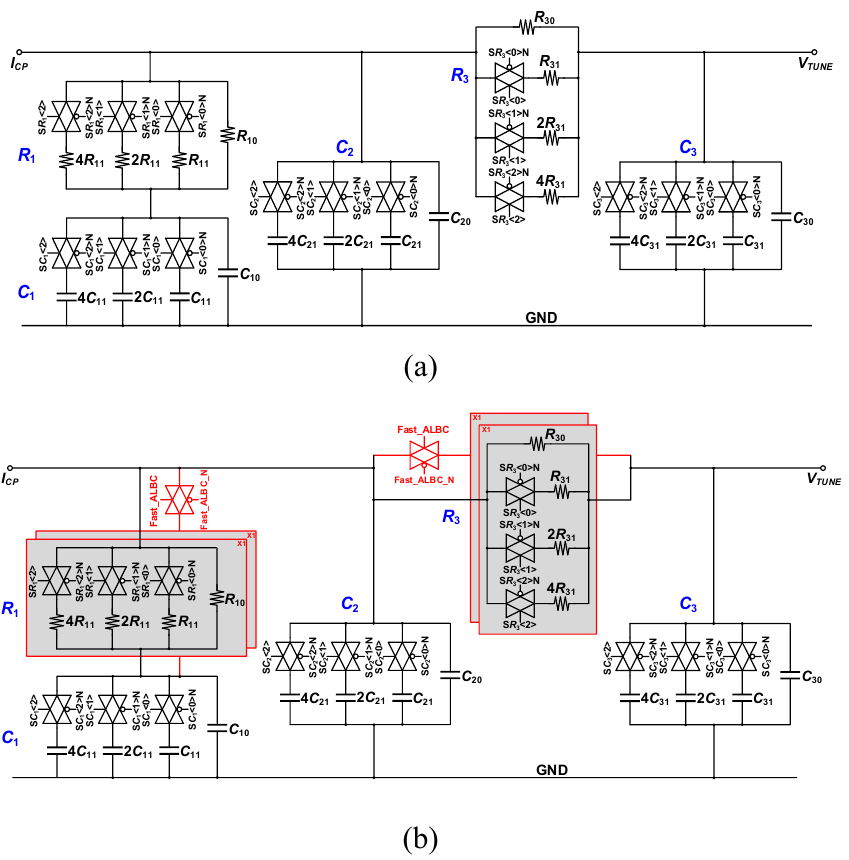
Figure 3. ( a ) The schematic of the programmable loop filter, ( b ) the programmable loop filter adding fast loop bandwidth switch by